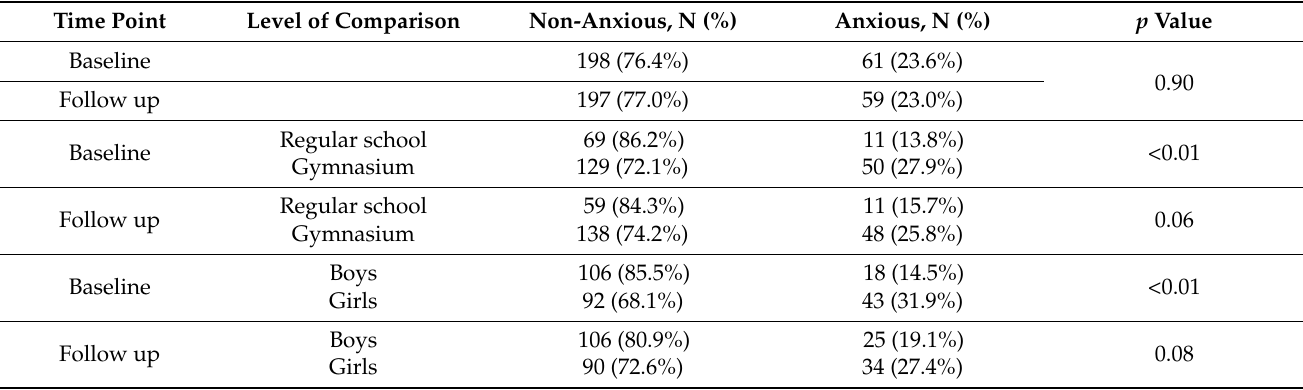
Table 4. Highly anxious students *, by time point and by